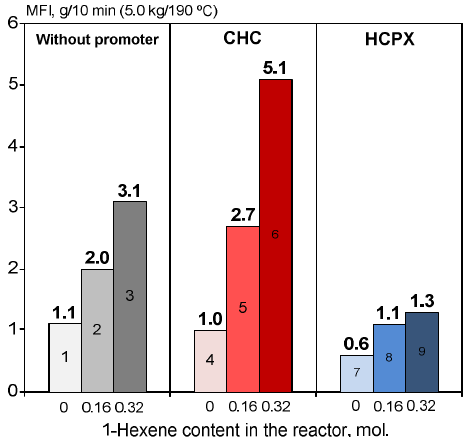
Figure 4. The effect of COCs on the MFI of PE samples. Upon 1-hexene/ethylene copolymerization (monomer ratio, 0.57) over TMC, the MFI